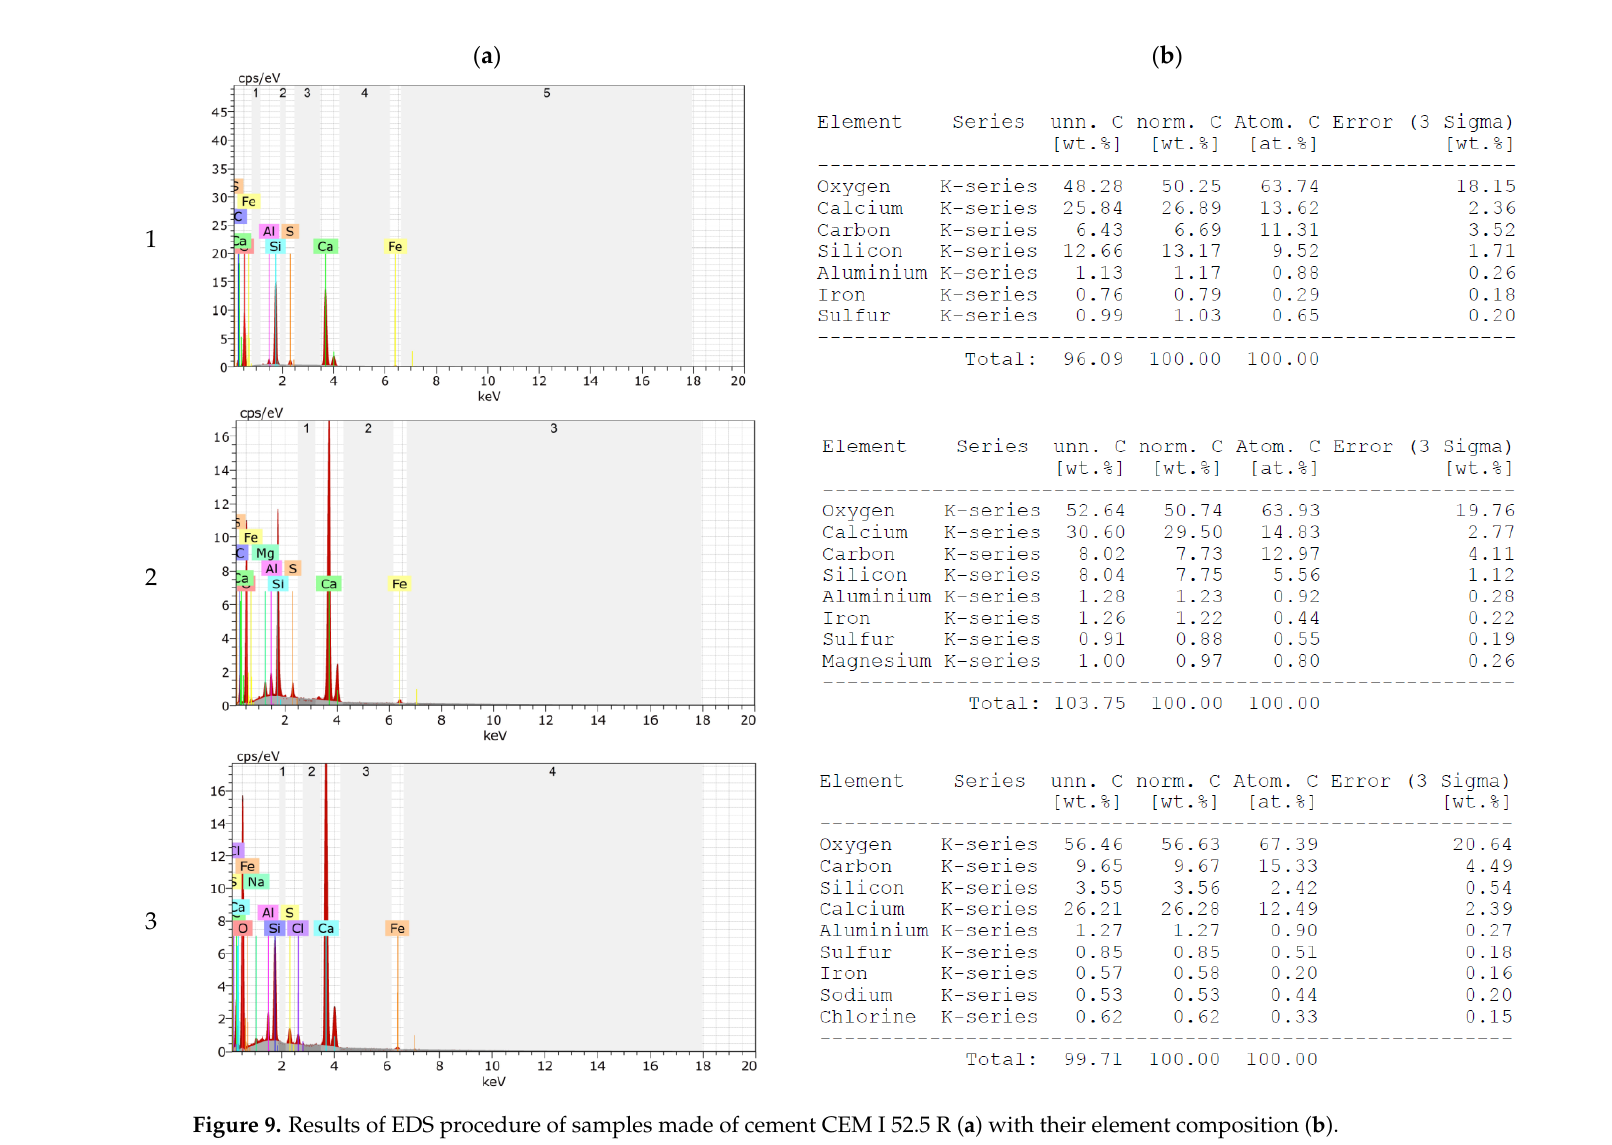
Figure 9. Results of EDS procedure of samples made of cement CEM I 52.5 R ( a ) with their element composition ( b ).